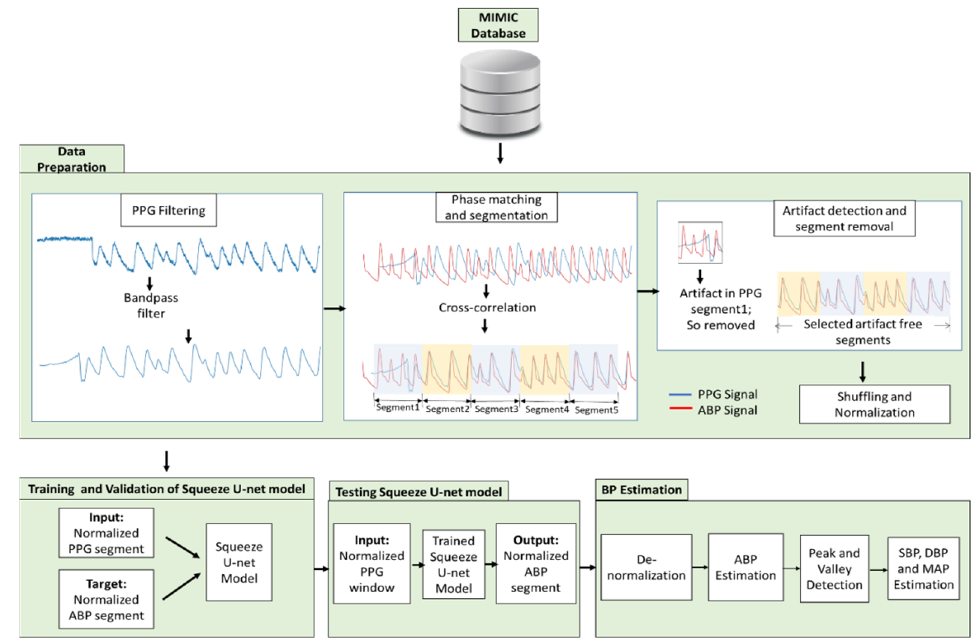
Figure 1. Proposed methodology to train, validate, and test the proposed Squeeze U-net model.